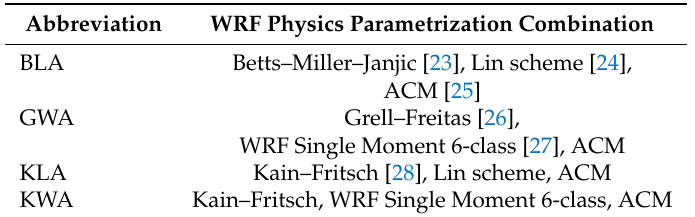
Table 1. Weather Research and Forecasting (WRF) physics parameterization combinations used in this study (first letter of the abbreviation represents the cumulus convection scheme, the second the microphysics scheme, and the third the planetary boundary layer, which is the Asymmetric Convective Model (ACM) in all